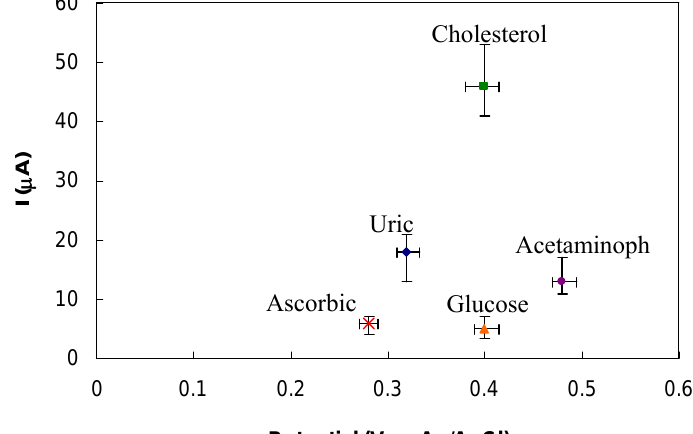
Figure 8. Oxidation peak current vs. corresponding peak potential of cholesterol (200 mg/dL), ascorbic acid (1 mg/dL), glucose (150 mg/dL), acetaminophen (5 mg/dL) and uric acid (7 mg/dL). The error bars indicates the variation for five independent